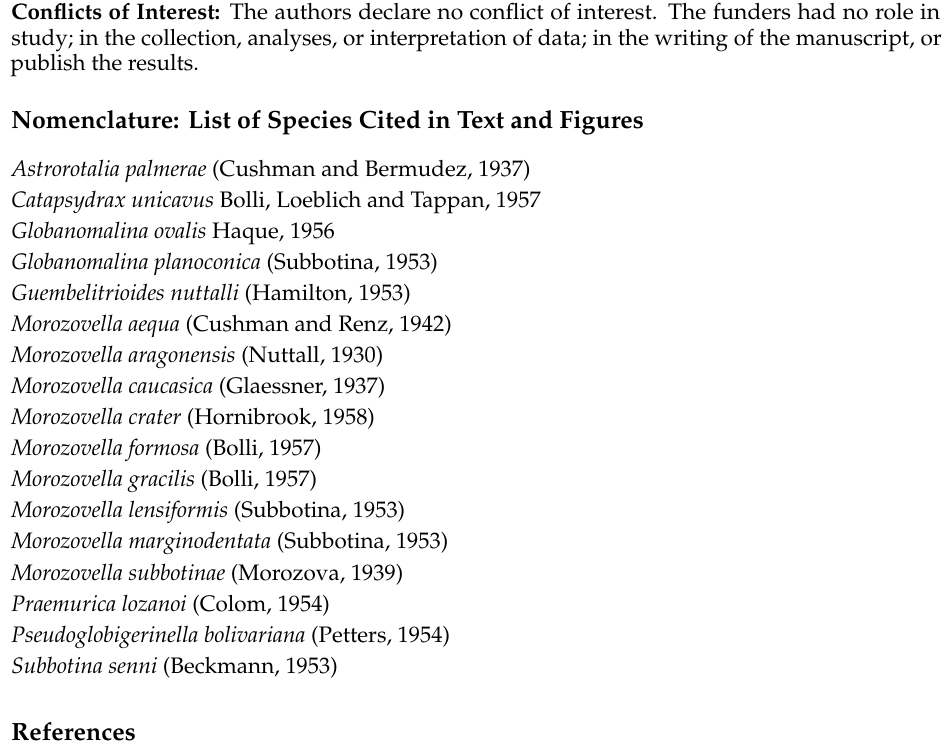
Table S1: Planktic foraminiferal abundance and F-index at Site 1258, Table S2: Morozovella species abundance at Site 1258, Table S3: Morozovella species abundance at Site 1263, Table S4: Morozovella species abundance at Site